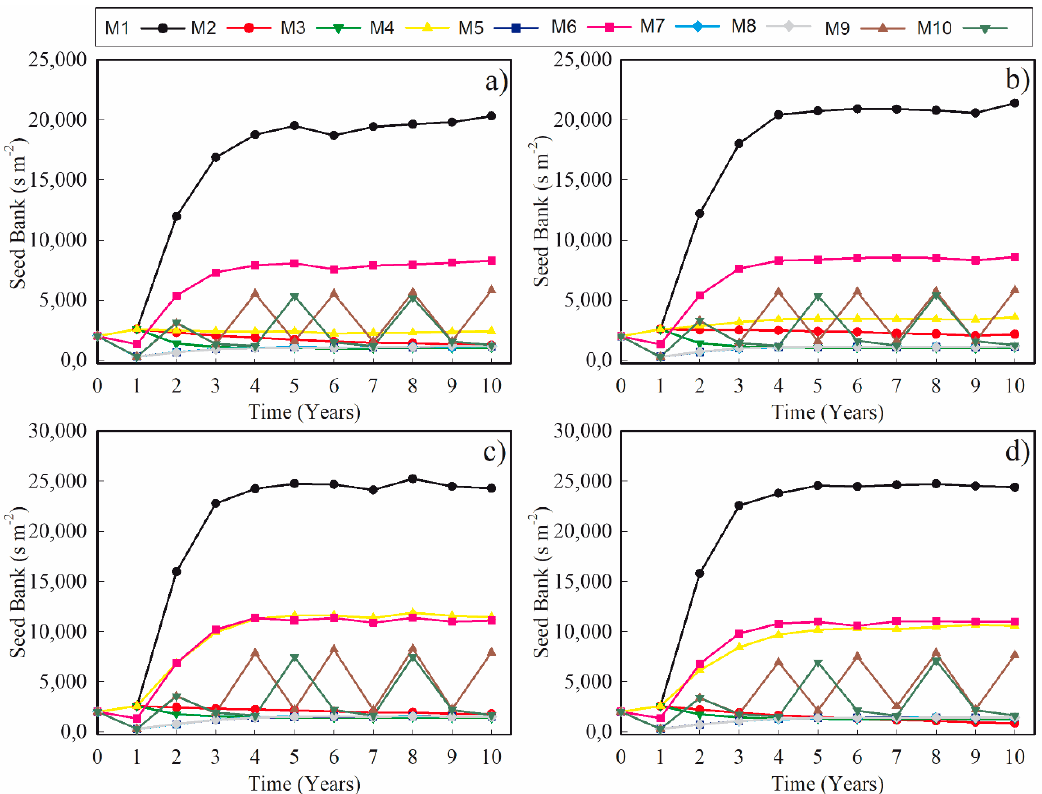
Figure 1. Average dynamics of Lolium multiflorum seed bank. For Scenario 1, mean temperature between 2007 and 2017 for populations susceptible ( a ) and resistant to glyphosate ( b ), and for Scenario 2, with an expected average daily temperature increase in 2.5 °C for populations susceptible ( c ) and resistant to glyphosate ( d ). Under different management strategies. M1 = Null, M2 = PosLC1 + PosEC2, M3 = PosLC1 + PosLC2 + PosEC3, M4 = PosEC2 + PosLC3, M5 = Wheat/Soybean, M6 = Oat/Soybean, M7 = Oat/Corn, M8 = Wheat/Soybean/Oat/Corn, M9 = Oat/Soybean/Oat/Corn, M10 = Wheat/Soybean/Oat/Corn/Oat/Soybean.